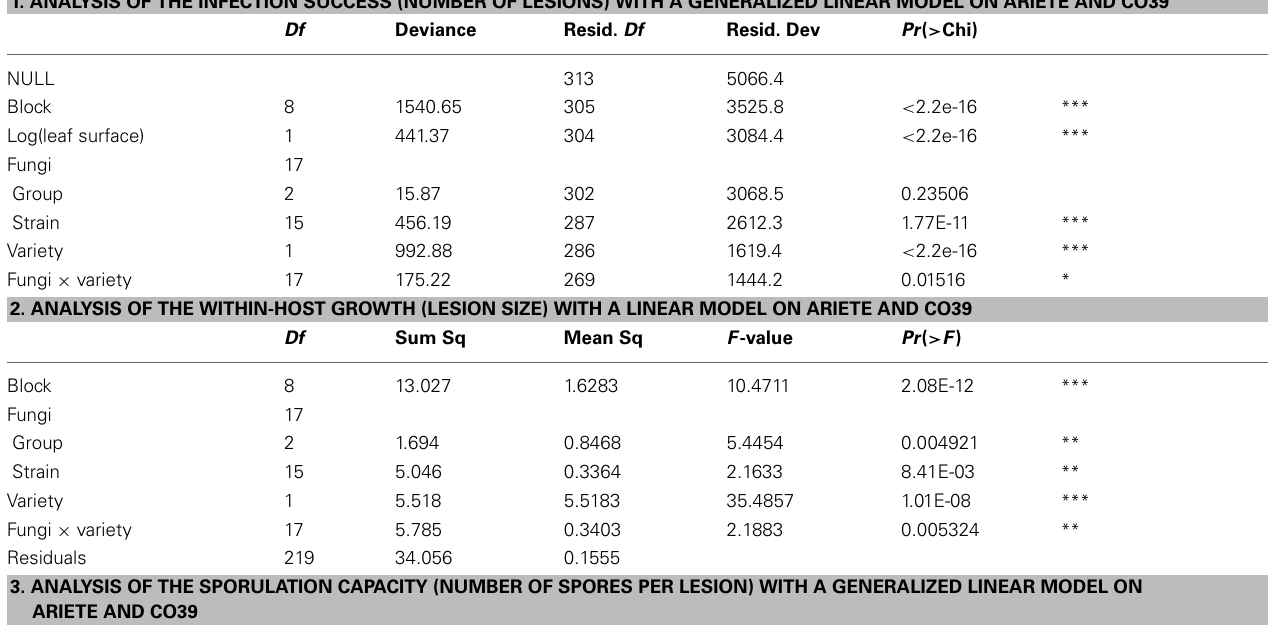
Table 2 | Statistical